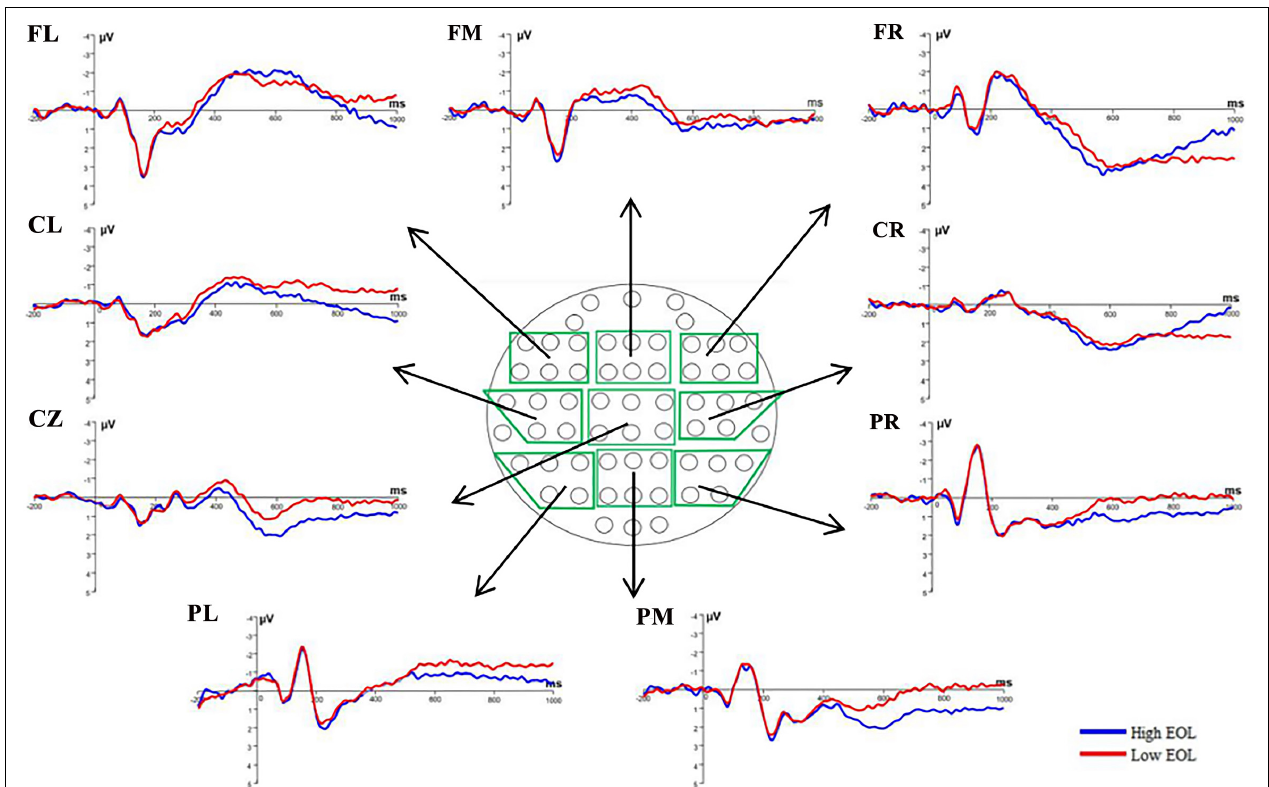
FIGURE 2 | Stimulus-locked event-related potential (ERP) grand average ( N = 32) in low (red line) and high (blue line) EOL judgment conditions is showed at one frontal-left electrode (F3), one frontal-middle electrode (Fz), one frontal-right electrode (F4), one central-left electrode (C3), one central-middle electrode (Cz), one central-right electrode (C4), one parietal-left electrode (P3), one parietal-middle electrode (Pz), and one parietal-right electrode (P4) were corrected as Stimulus-locked average ERP of each region of interest (ROI; N = 32) in low (red line) and high (blue line) EOL judgment conditions are showed at frontal-left (FL) ROI, frontal-middle (FM), frontal-right (FR), central-left (CL), central-middle (CM), central-right (CR), parietal-left (PL), parietal-middle (PM), and parietal-right (PR). The nine ROIs for ERP analysis are marked with green color in the middle head